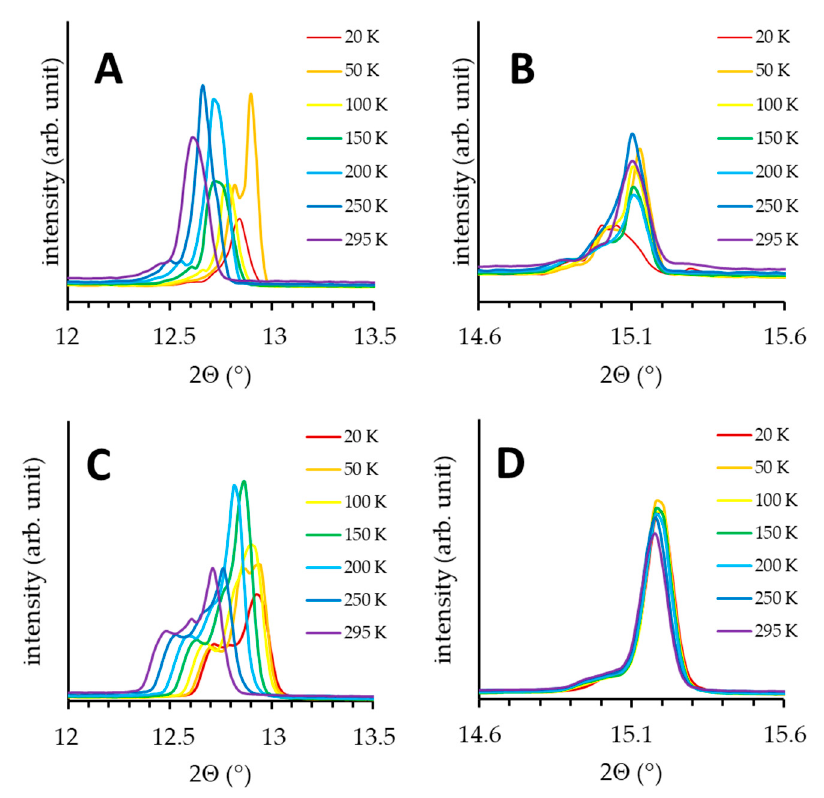
Figure 6. Temperature behaviour of (002) ( A , C ) and (0-11) ( B , D ) reflections of SA top ( A , B ) and SA-C 6 D 5 bottom ( C , D ) panels.